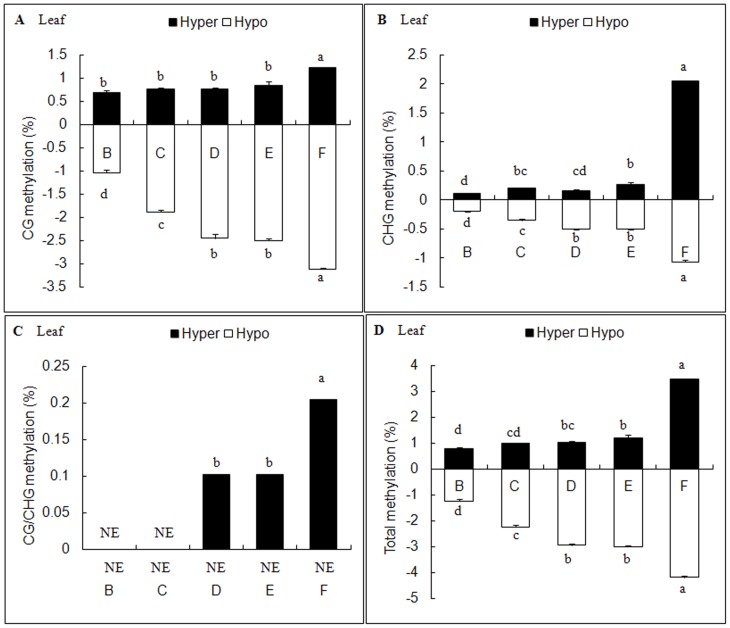
Effects of different salt stresses on methylation variation in C.virgata leaves.B: NaCl, C: Na2SO4, D: NaHCO3, E: Na2CO3, F: Mix. Data represent means ±S.E. of four replicates. Different lower-case letters represent significant difference among treatments at the 5% level, according to least significant difference (LSD) test. NE: Not exist.